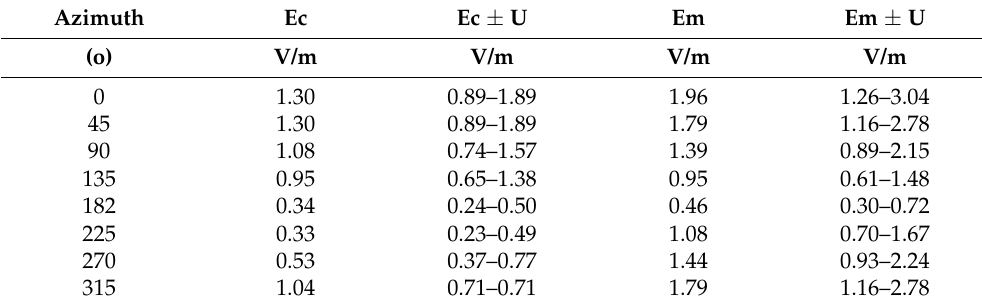
Table 6. The results of measurements and calculations of E-field near MO-RFID reader (at 3 m away).